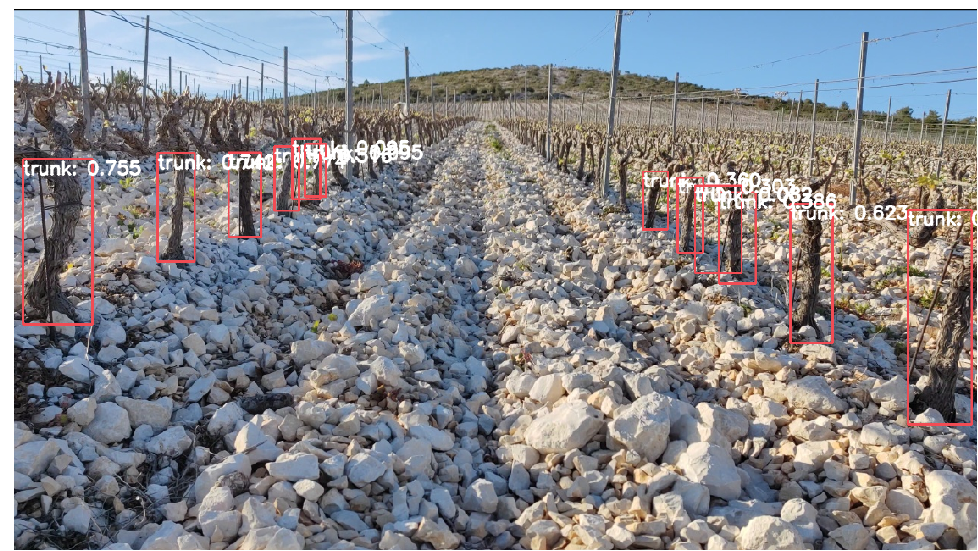
Figure 9. Example of vine trunk detection in a vineyard on rocky terrain in Lubarda, an example of a soil composition usually found in regions with karstic geological topography.